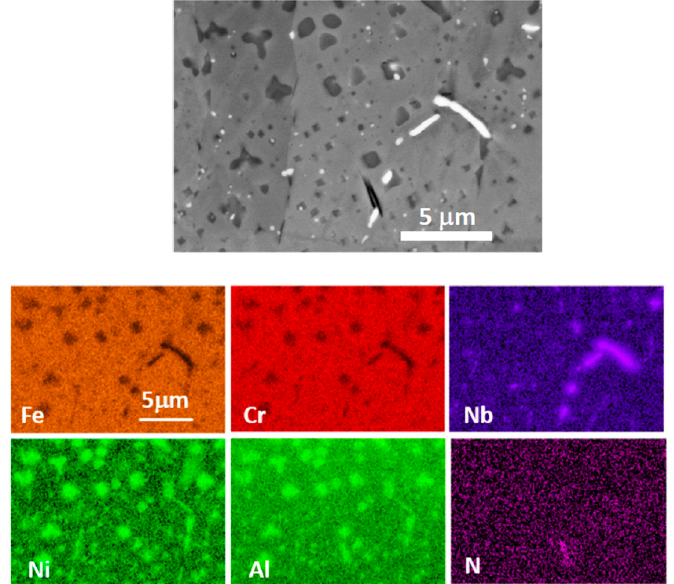
Figure 4. FESEM cross section of the most internal layer (zone 3 in Figure 1) of the slurry aluminide coating deposited on HT347HFG steel.